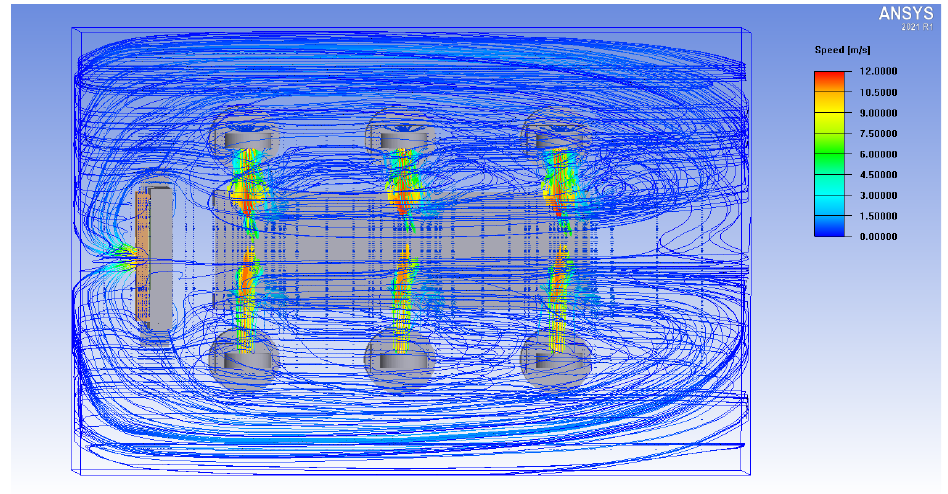
Figure 30. Air purifier simulation top view in the conference room at a high rotation speed -2.